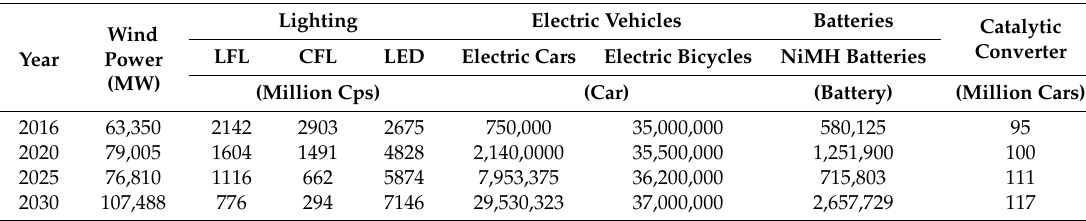
Table 1. Overview of global clean technologies demand at